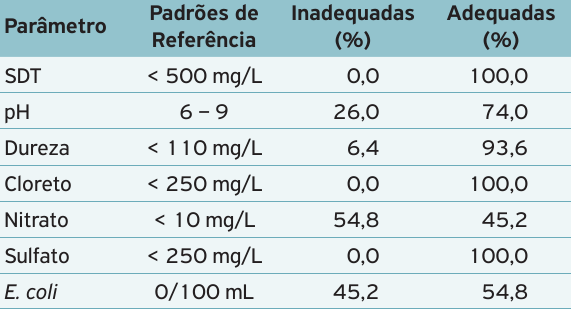
Tabela 1. Qualidade da água de granjas de postura comercial da região Sul de Santa Catarina em adequação aos padrões indicados pelo Ofício Circular Conjunto DFIP/DSA nº